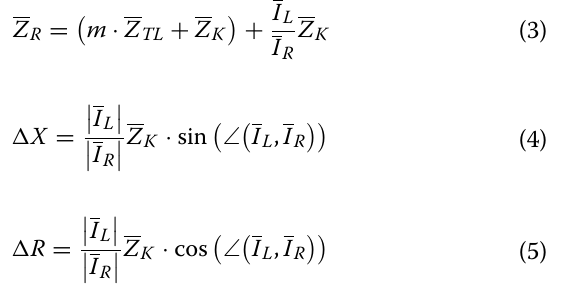
phasor fault current contributions of the TL terminals, (cid:31) R and is the phasor fault impedance. This fault is ∈ + protected from both TL ends as shown in Fig. 5. In gen- eral Z K can be represented as a resistance ( Rf ).